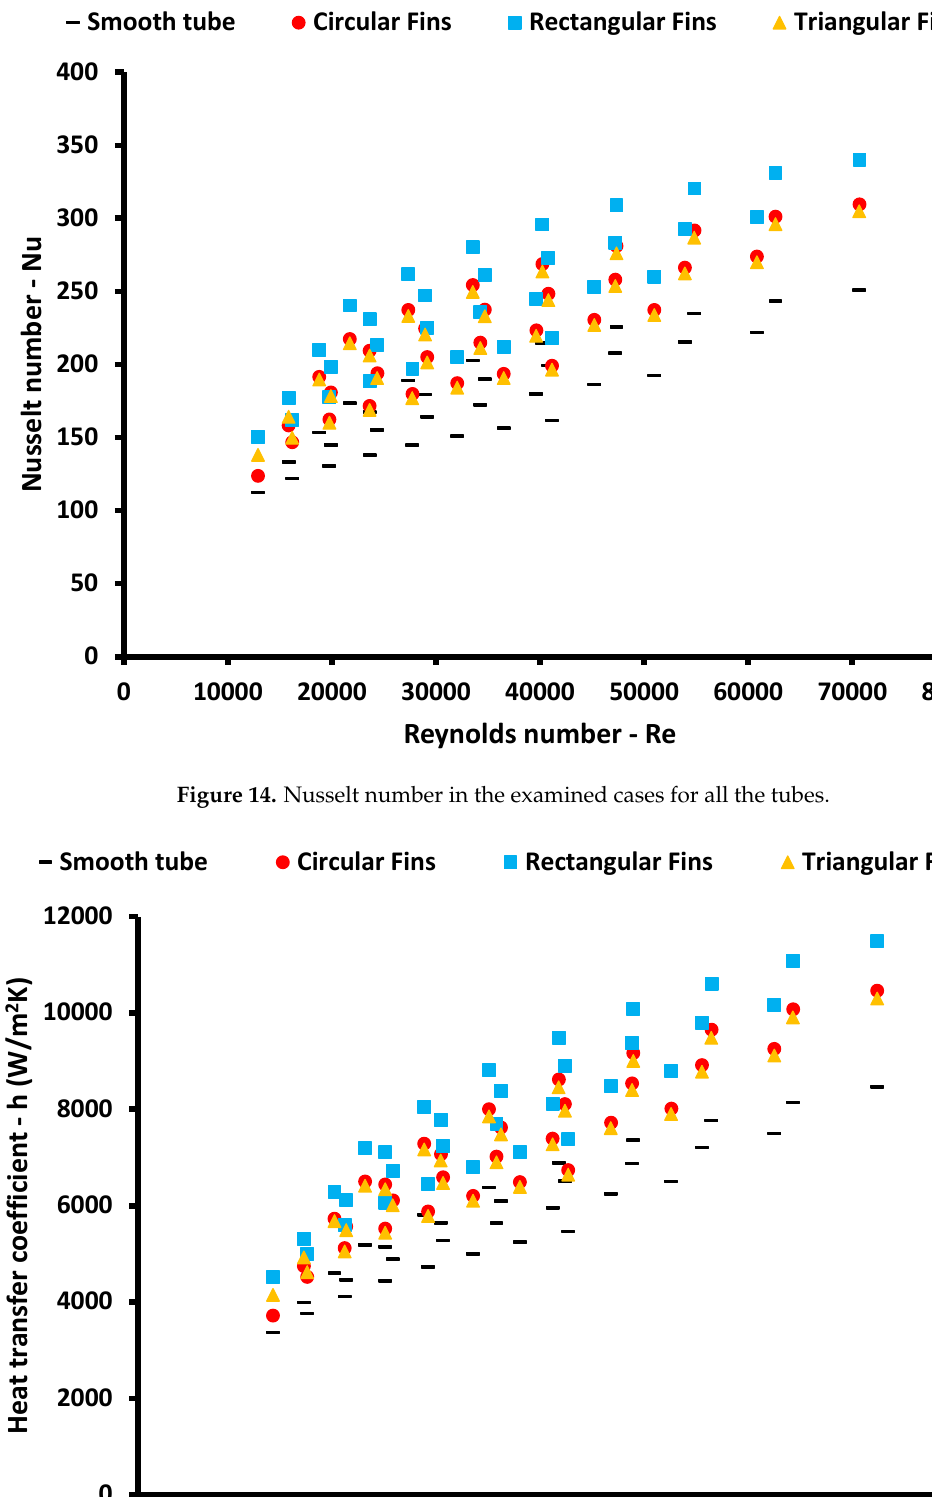
Figure 16. Friction factor in the examined cases for all the tubes.